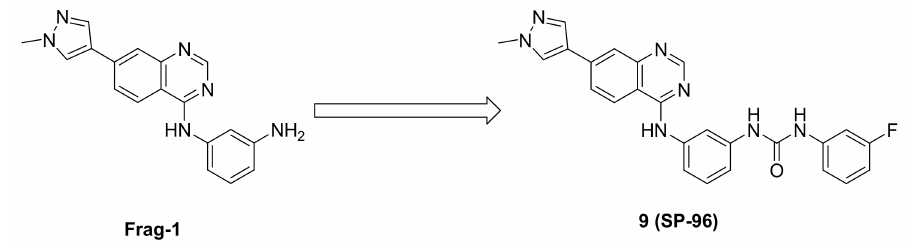
Figure 17. Modification to Frag-1 to form compound 9 ( SP-96